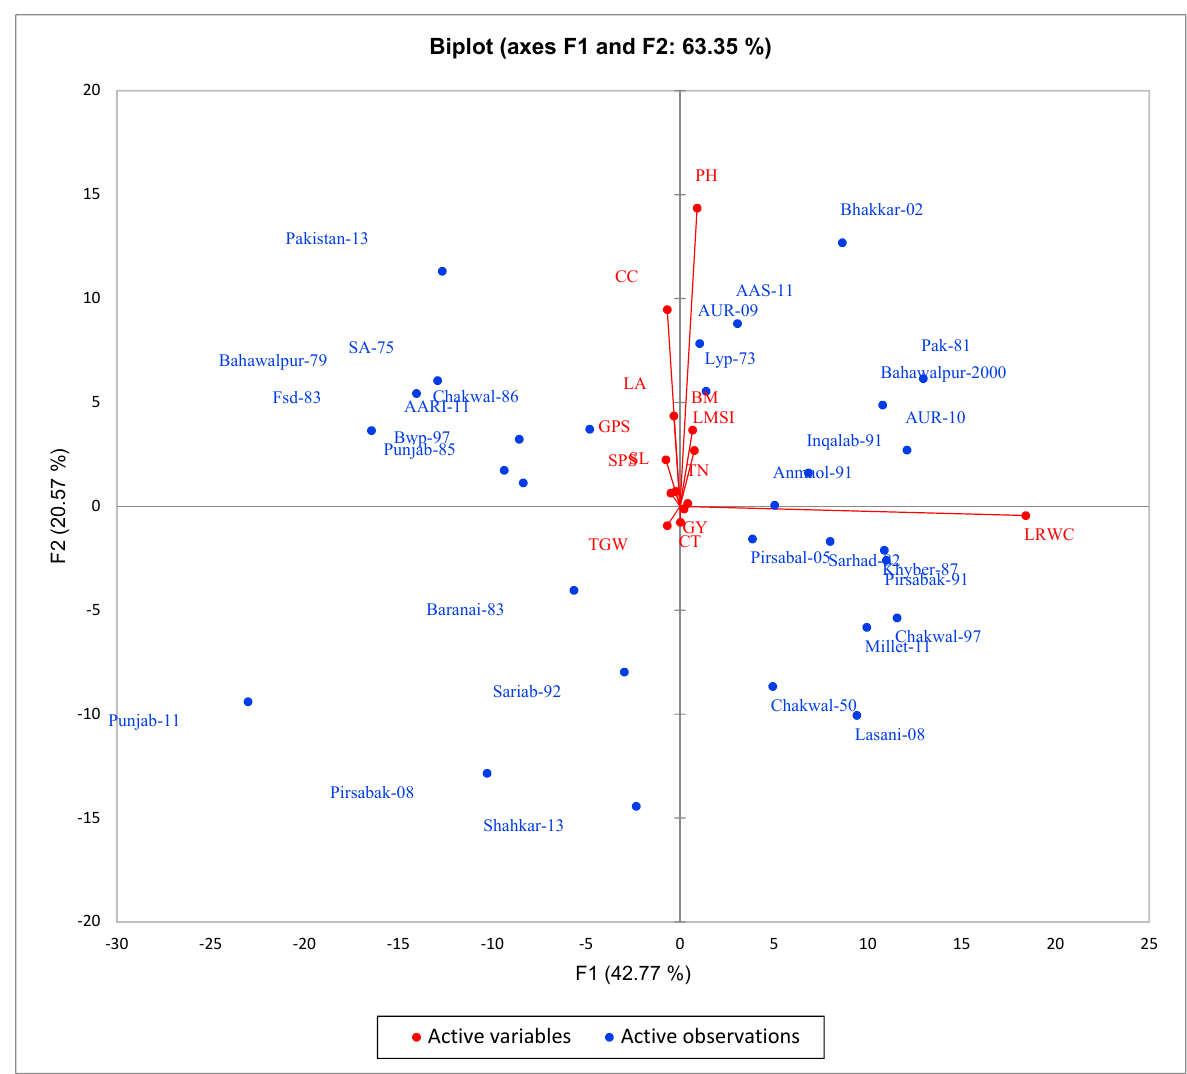
Figure 3. Biplot scattering genotypes into different quadrants based on the extent of trait association. Chl, chlorophyll; CT, canopy temperature; CMPS, cell membrane percentage stability; LRWC, leaf relative water content; FLA, flag leaf area; PH, plant height; TPP, tillers plant − 1 ; SL, spike length; SPS, spikelet spike − 1 ; GPS, grains spike − 1 ; GYP, grain yield spike − 1 ; TGW, thousand grain weight; PBM, plant biomass.